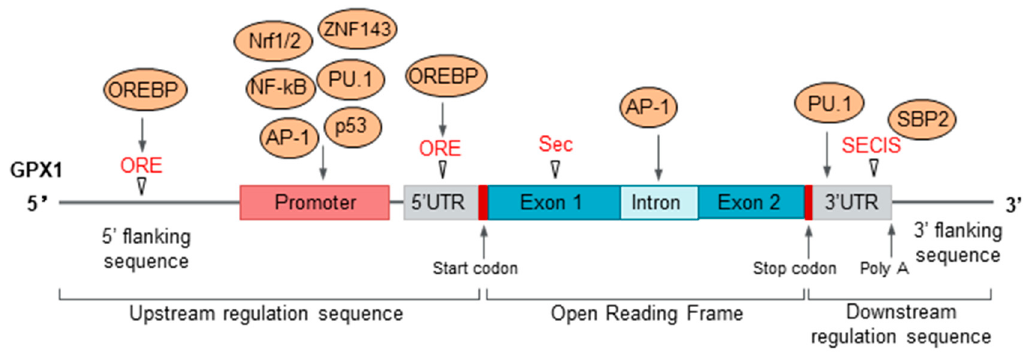
Figure 2. Schematic diagram of GPX1 gene expression and activity regulation. At the GPX1 locus, there is a selenocysteine codon sequence in exon 1, a Sec insertion sequence (SECIS) in the 3’ UTR, and two oxygen-responsive elements (ORE) in the pro- moter. The yellow circles represent the transcription factors or DNA-binding proteins that bind to the GPX1 locus, which participate in the transcriptional, post-transcriptional, and translational regulation of GPX1. NF-kB: nuclear factor kappa B, AP-1: activating protein 1, ZNF143: zinc finger protein 143, Nrf1/2: Nuclear respiratory factor, OREBP: Oxygen- responsive element-binding protein, SBP2: SECIS-binding protein 2.